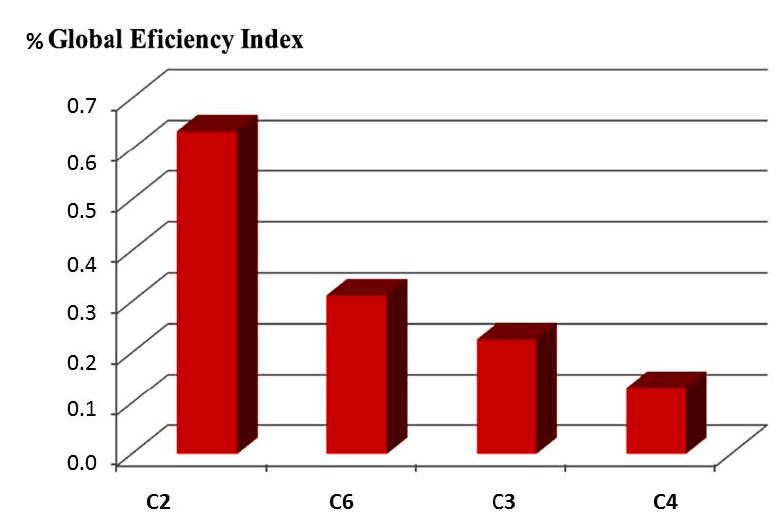
Figure 28. Comparison of calculated values of GEI for C2, C3, C4 and